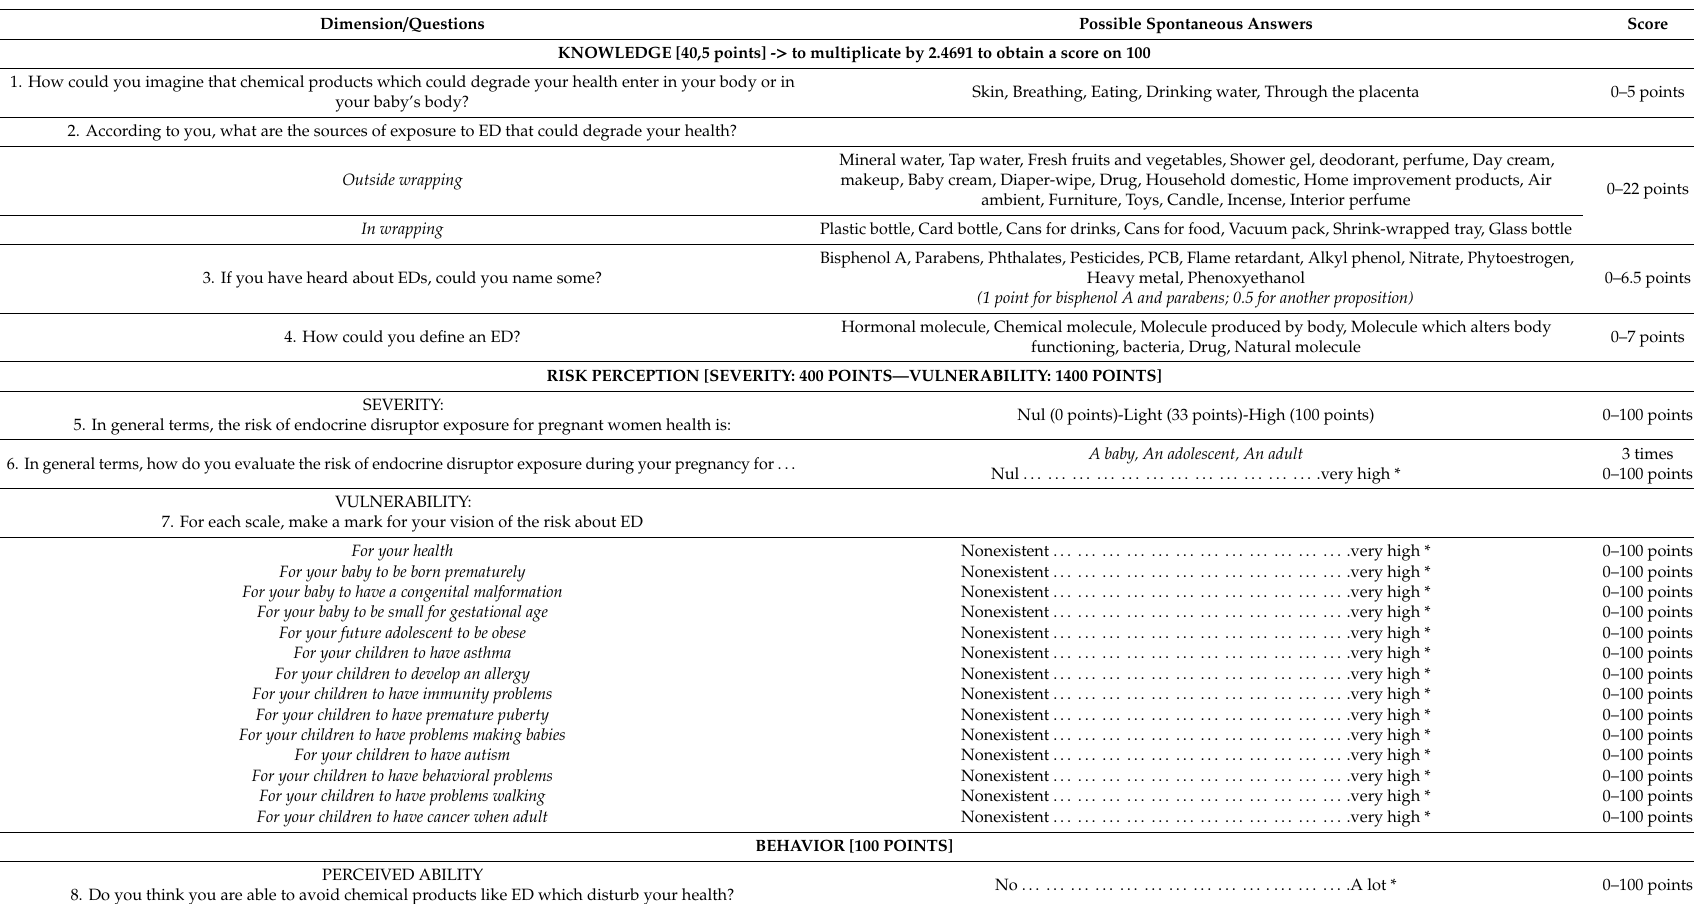
Table 3. Part of the PREVED © questionnaire that could be used in consultation or